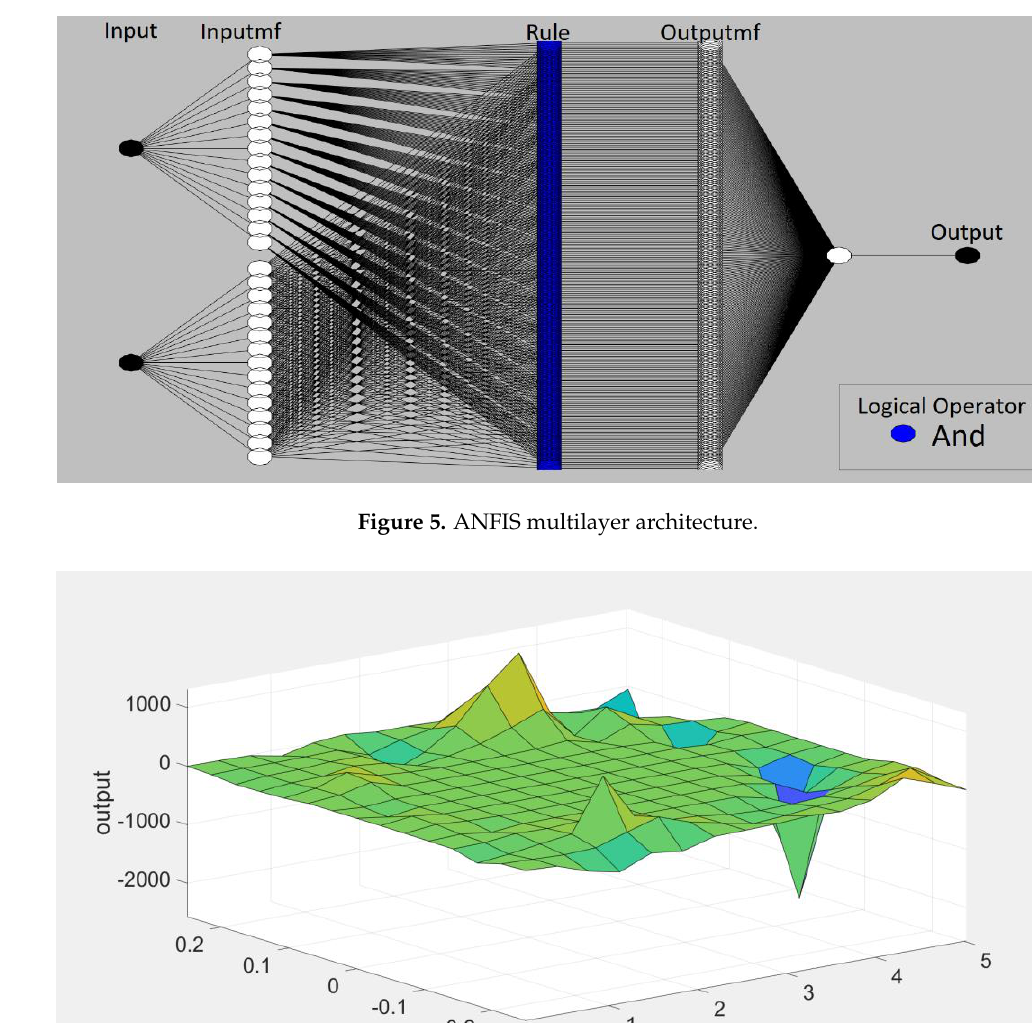
Figure 4. Membership functions of the input pressure derivative.